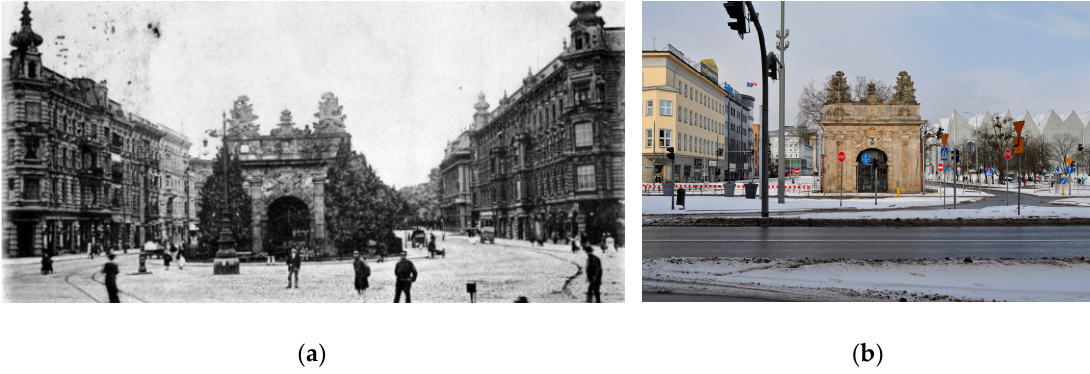
Figure 1. The King’s Gate in Szczecin, both photos were taken from a similar place, and show the southern facade of the building: ( a ) before 1939, the building was symmetrically surrounded by perimeter blocks with eclectic-style tenement houses from the turn of the 20th century ( source: sedina.pl); ( b ) nowadays, the composition of the King’s Gate surroundings has been ‘disturbed’ as a result of the liquidation of the quarter, which was located on the site of the present Solidarity Square. In the foreground, one can see the extension of the road communication system of the Castle Route (Trasa Zamkowa) (source: created by author).